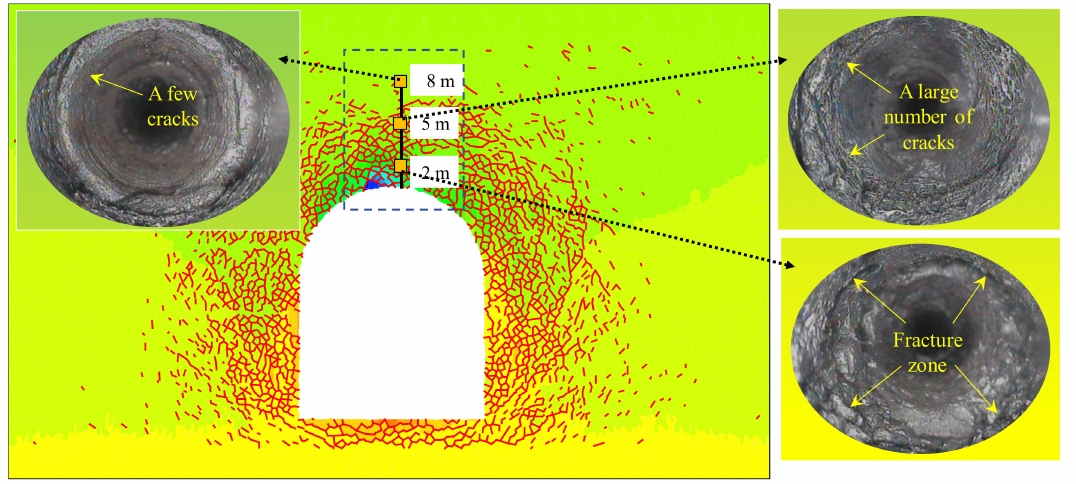
Figure 11. Crack development in the chamber dome.